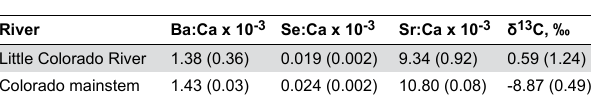
Table 2. Means (± s.e.) of barium, selenium, and strontium relative to Ca, and δ 13 C collected over 3 years (May 2009 – October